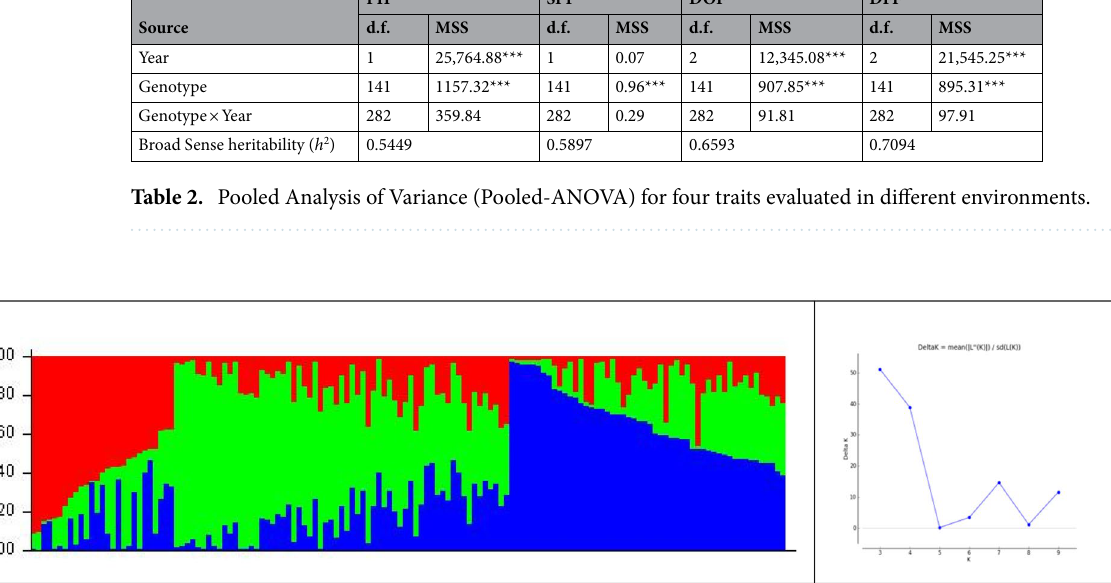
Figure 2. Population structure analysis revealed three major clusters in the pigeonpea mini core